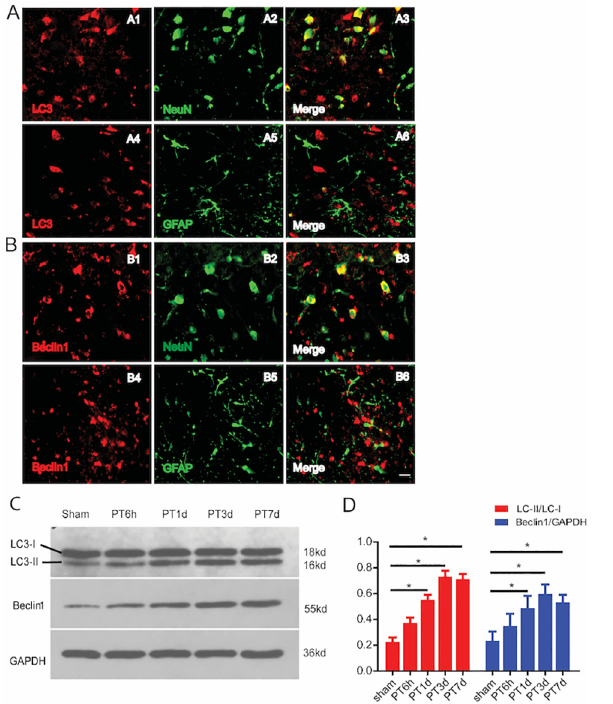
Fig 3. Cellular expression of LC3 and Beclin1 following ischemicstroke. A, Double-staining for LC3 (red) and NeuN (green) showedthat numerousLC3-positive cells were colocalized withinneuronsin the cortex (A1-A3). However, stainingagainst LC3 and GFAP showedthat very few LC3-positive cells were colocalized with astrocytes in the lesioncore surroundedareas, 1 day post stroke (A4-A6). B, Immunofluorescent staining againstBeclin1(red) and GFAP (green) showedthat Beclin1positivecells were mainlycolocalizedwith neuronsin the cortex insteadof astrocytes (B1-B3). Scale bar represents 20 μ m. C, The expression of LC3 and Beclin1was assessedby westernblotting at 6 h, 1 day, 3 days, and 7 days post injury. D, The expression of autophagosomespeakedat 3 days and then decreasedslightly at 7 days. (n = 4 for eachgroup, * p < 0.05 vs. sham group, ** p < 0.01 vs. sham group, one-wayANOVA with Tukey post hoc test).